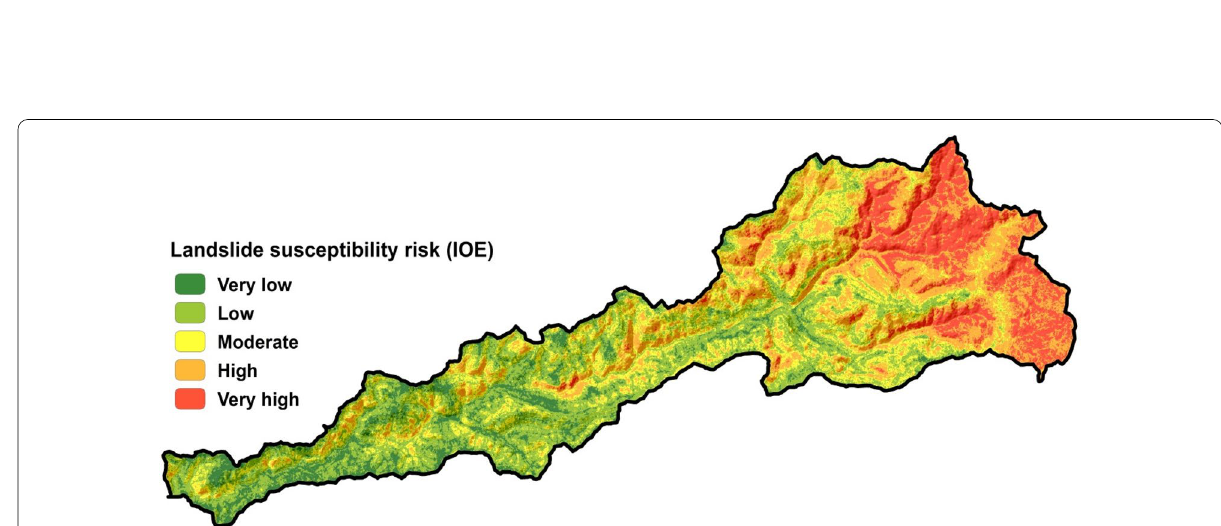
Fig. 6 Landslide susceptibility map obtained from the IOE model